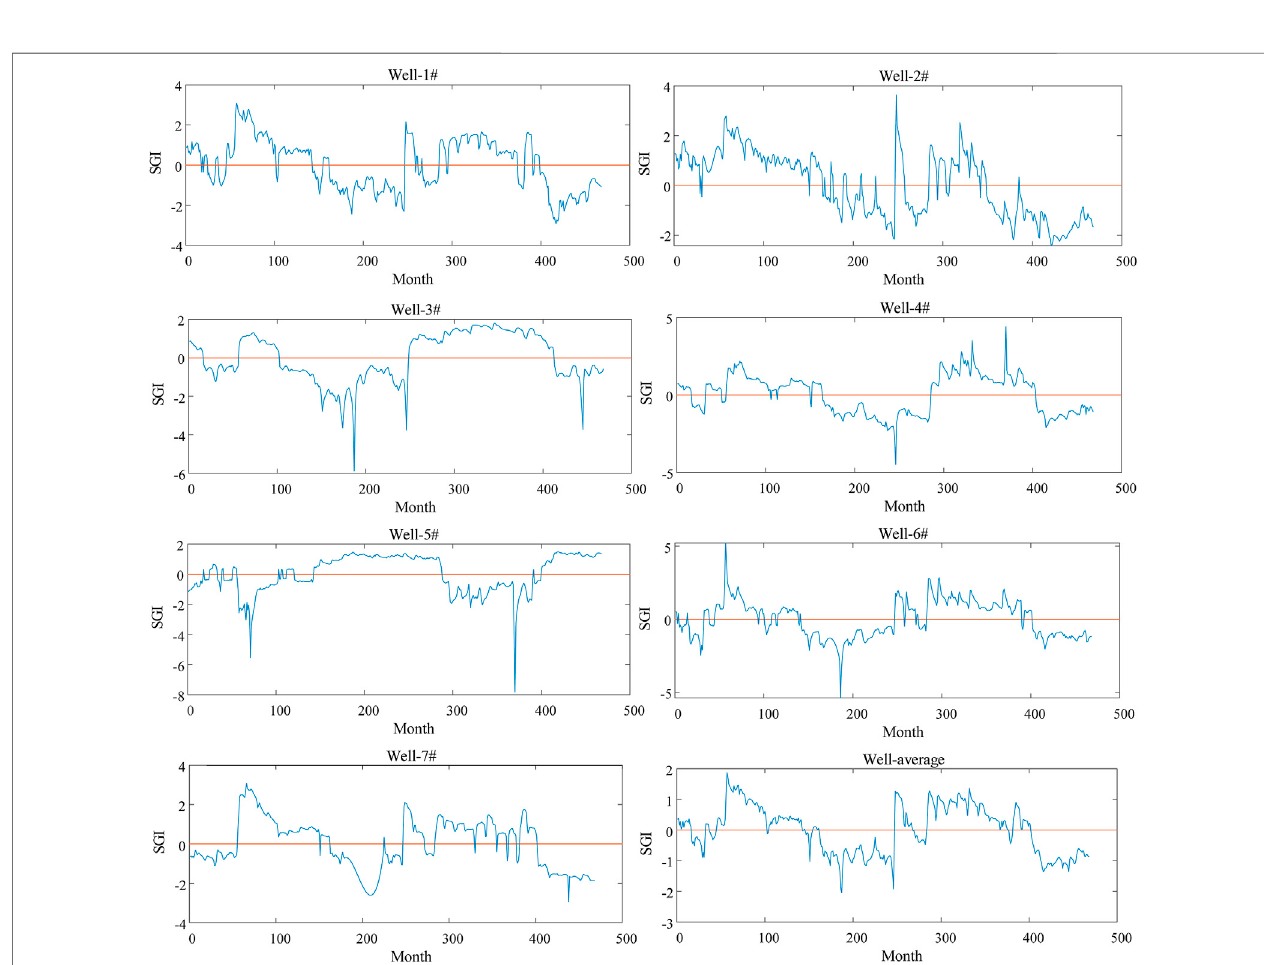
FIGURE 3 | SGI time series